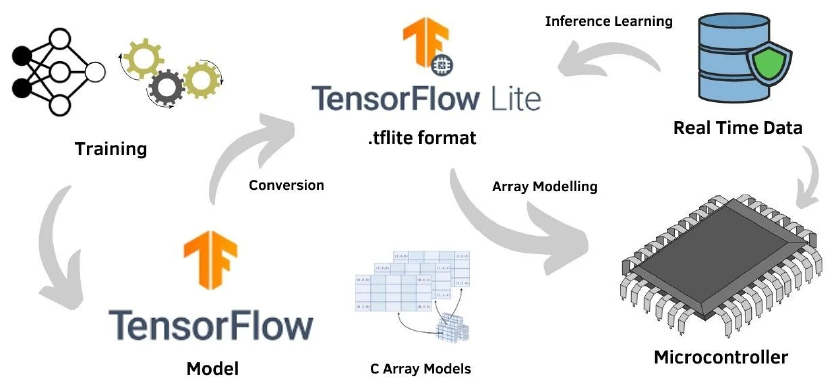
Figure 12. Workflow of TensorFlow Lite